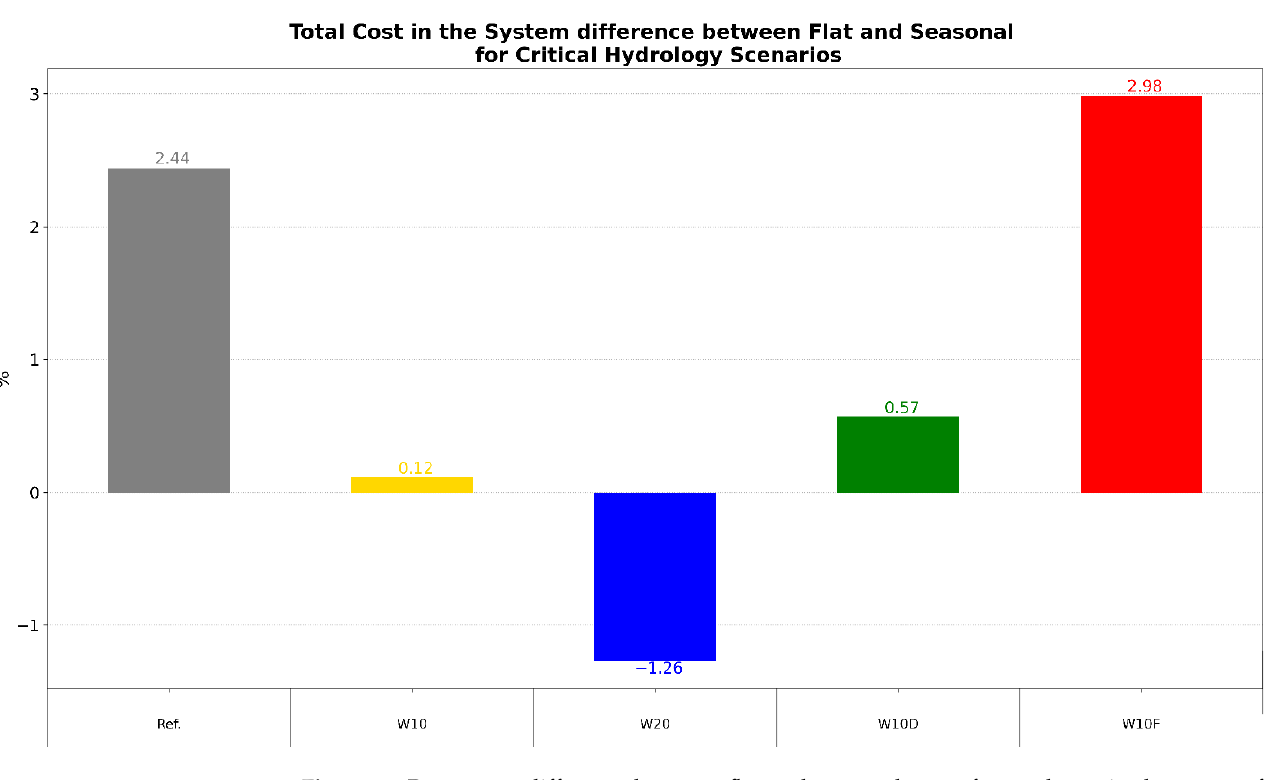
Figure 6. Percentage difference between flat and seasonal cases for average thermal cost in the southeast subsystem for scenarios with critical hydrology.